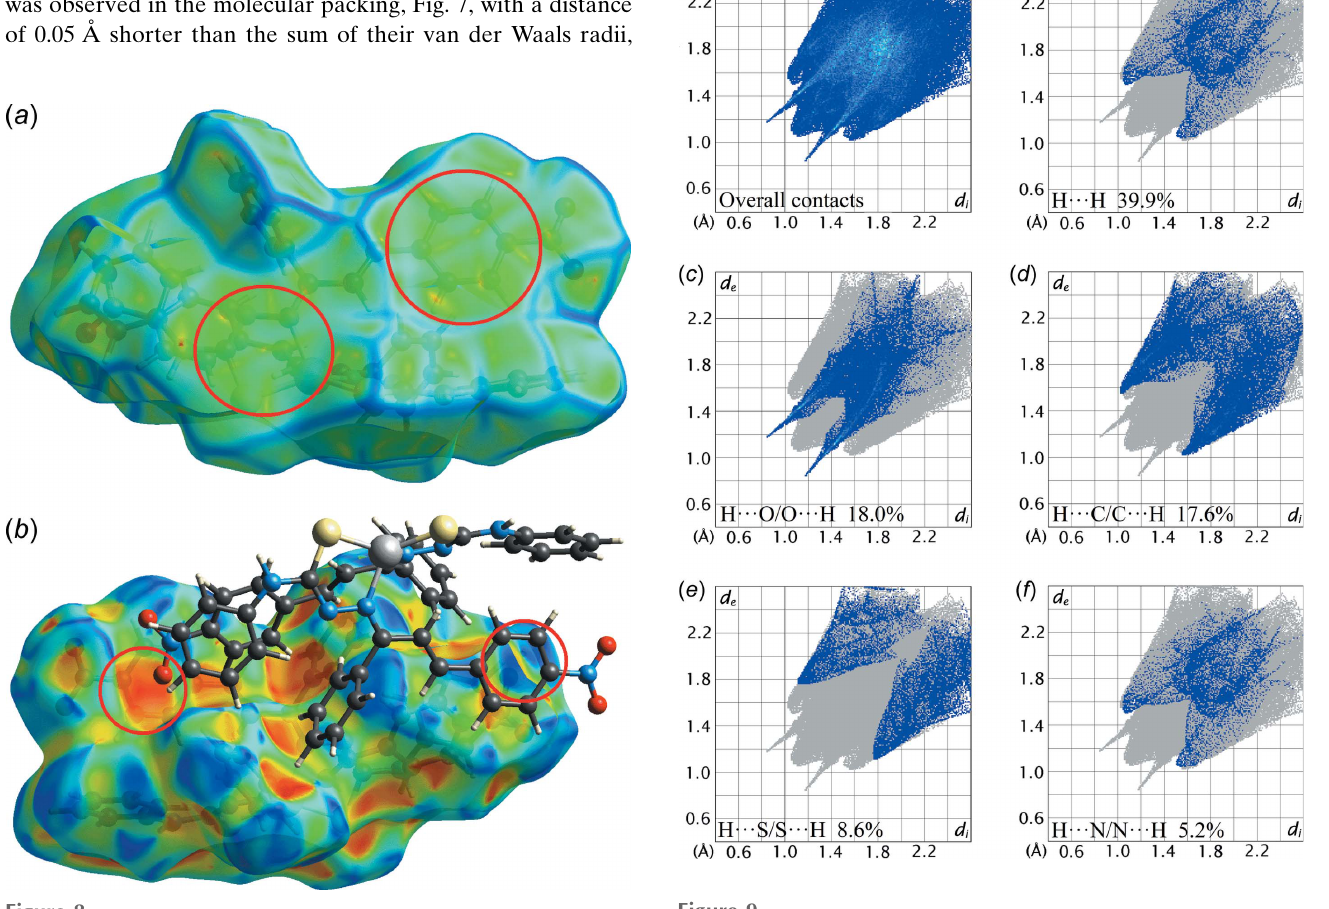
Figure 8 Views of the Hirshfeld surface mapped over ( a ) curveness and ( b ) the shape index property highlighting the intermolecular (cid:2) – (cid:2) and N—O (cid:3)(cid:3)(cid:3) (cid:2) interactions, respectively.